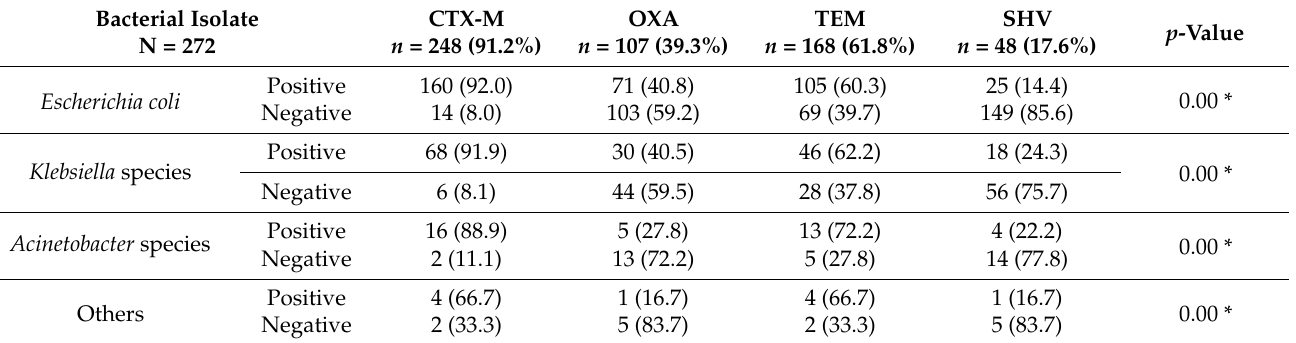
Table 3. Distribution of ESBL coding genes among GNB bacteria isolated from clinical specimens.